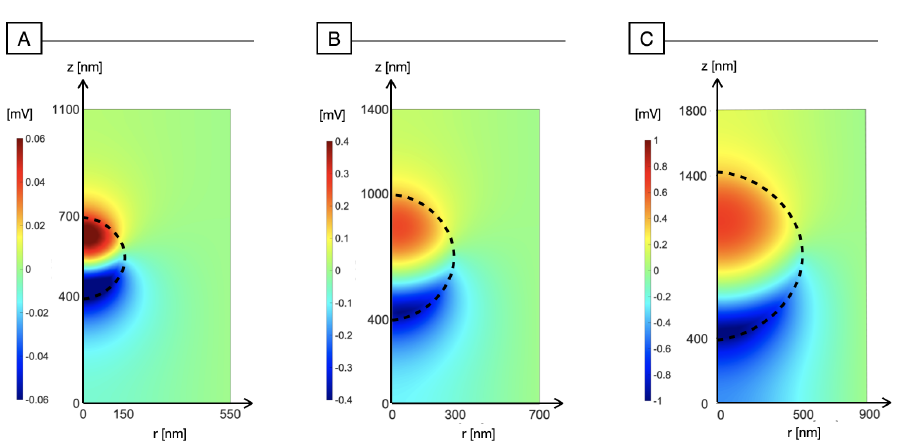
Figure 2. Electric potential distribution ( mV ) across the nanoparticle and the surrounding medium for increasing values of R NP : ( A ) R NP = 150 nm; ( B ) R NP = 300 nm; ( C ) R NP = 500 nm.